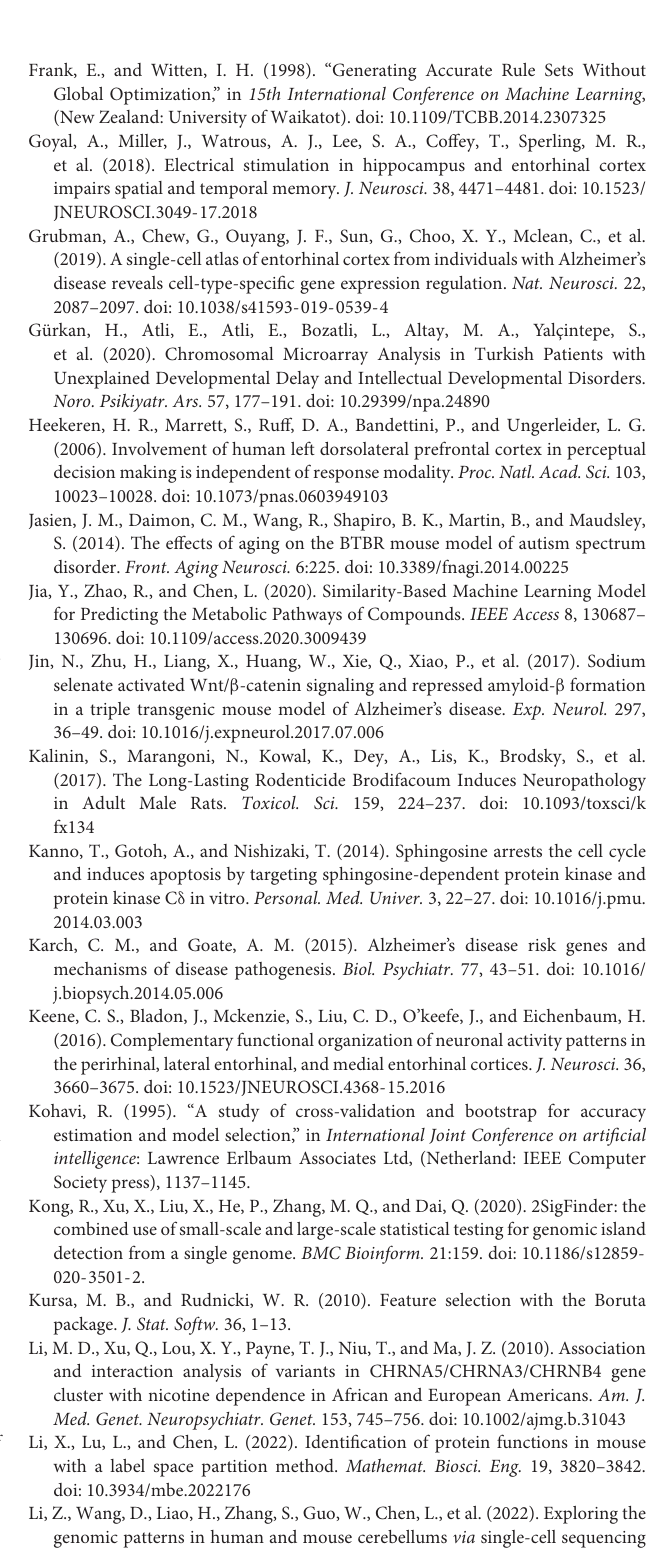
Supplementary Table 4 | Performance of IFS for DLPFC brain structure. Supplementary Table 5 | Performance of IFS for HIPPO brain